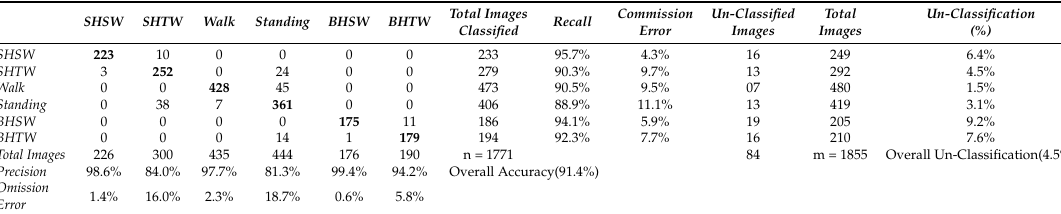
Table 10. Classification matrix for the complete